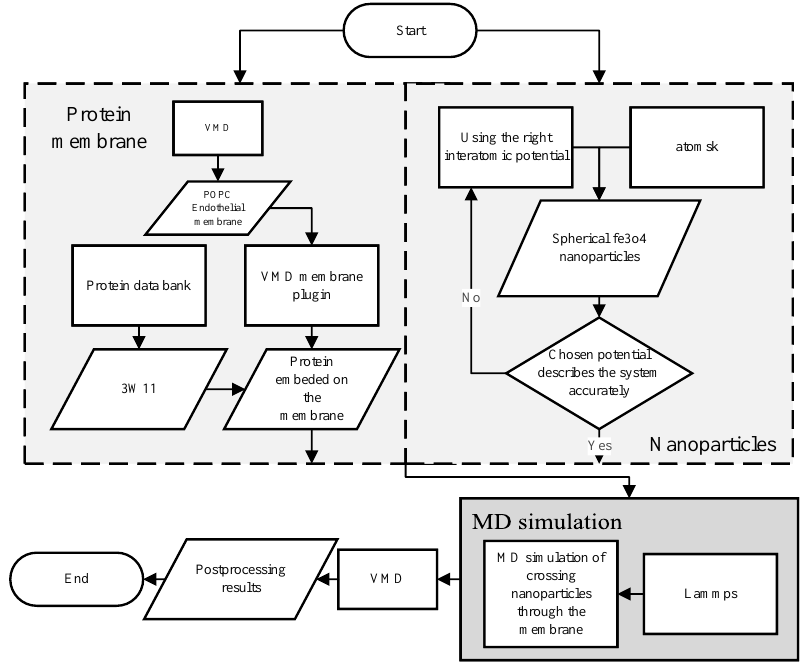
Figure 3. The flowchart of the MD simulation